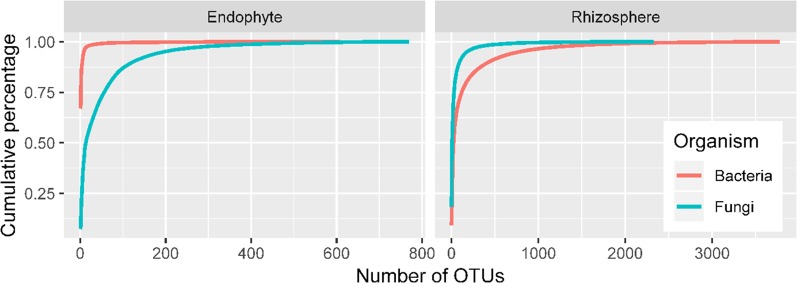
Accumulated proportion of sequence reads plotted against the number of OTUs; the OTUs were arranged in a descending order of their total counts across the 27 samples.